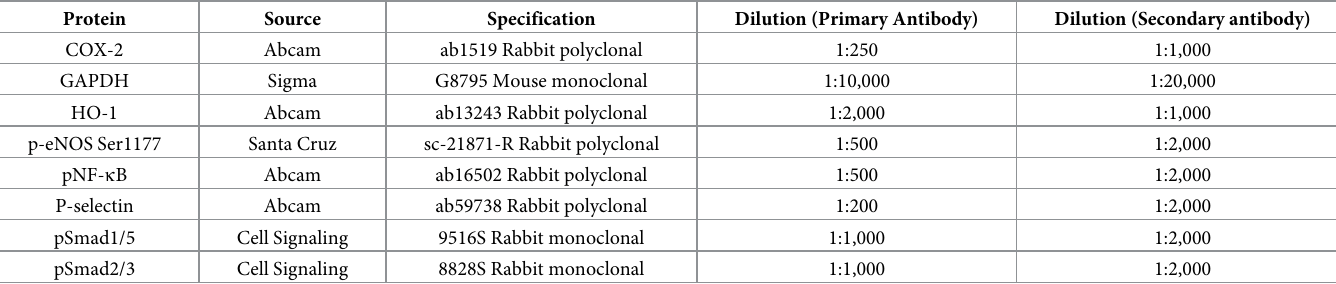
Table 1. Primary and secondary antibodies used for Western blot